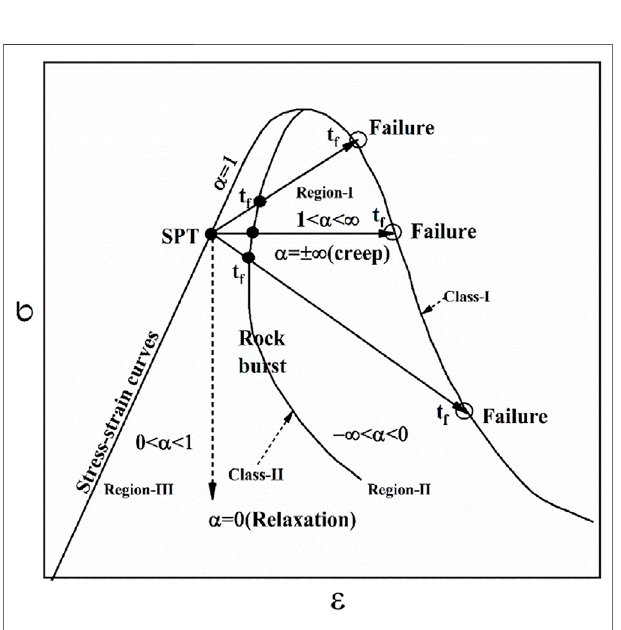
FIGURE 9 | Rheological failure of Class I and II